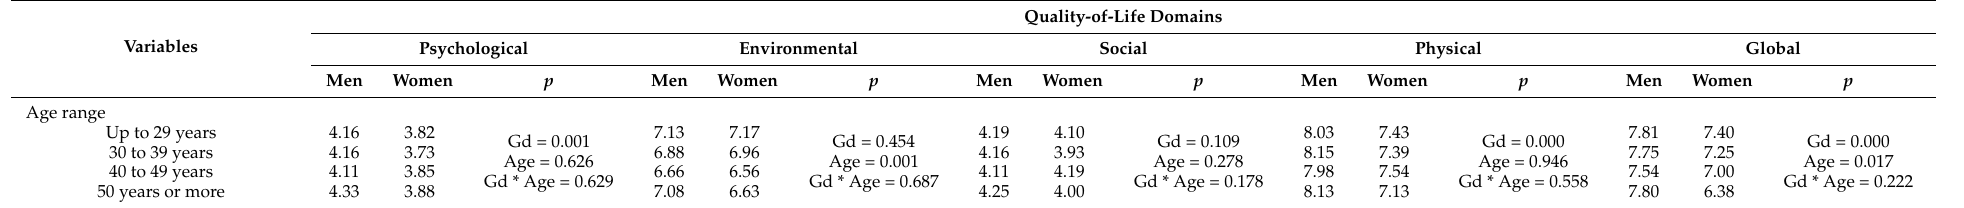
Table 3. Mean quality-of-life scores, stratified by gender and domains, for each sociodemographic, economic, and behavioral